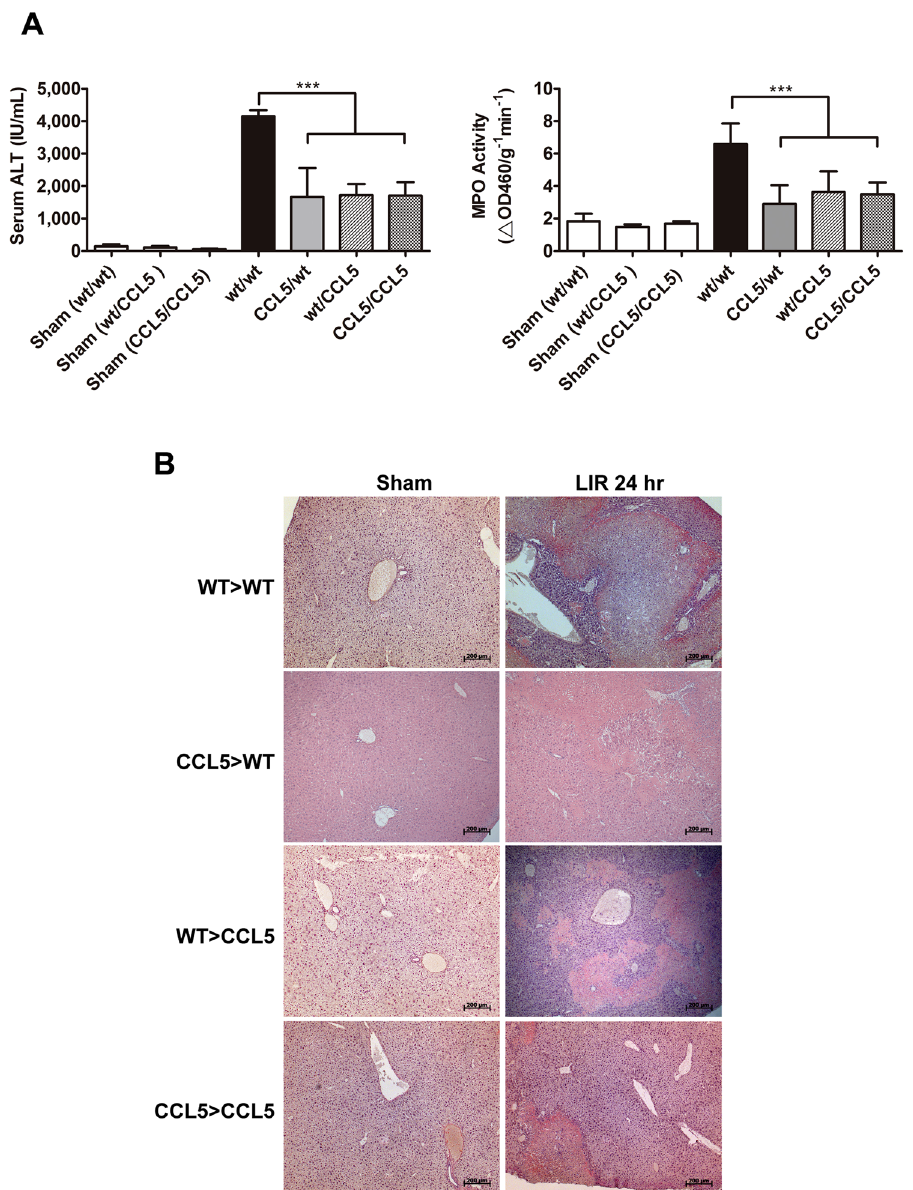
Figure 5. Deficiency in blood cell-and tissue-derived CCL5 resulted in reduced liver damages. C57BL/6C or CCL5-KO mice receiving either wildtype or CCL5-KO bone marrow (BM) cells after lethal irradiation were studied after 8 weeks of repopulation (BMT chimera denoted by donor > recipience). The BMT chimera mice were subjected to 60 min of ischemia and 24 hours of reperfusion. ( A ) The serum ALT and tissue MPO activities were evaluated in BMT chimera. The results demonstrated that CCL5 deficient chimera of CCL5 > WT, WT > CCL5, and CCL5 > CCL5 had significantly lower level of ALT and MPO activities compared to WT > WT chimera (Mean ± SD, n = 10). *** p < 0.0001. ( B ) The histology (H&E stains) studies showed less area of necrosis in tissue sections obtained from BMT chimera. Scale bar = 200 μ